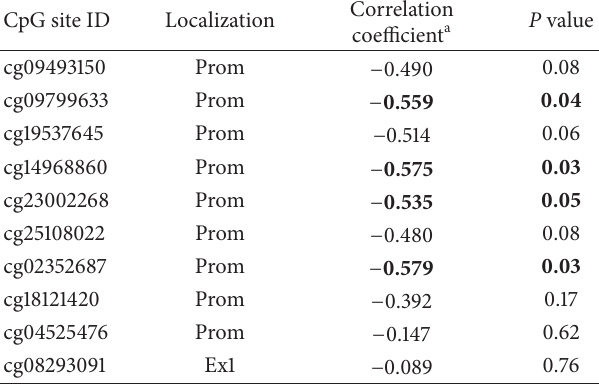
Table 6: Correlation of gene methylation with gene expression levels for SNPs-associated CpG